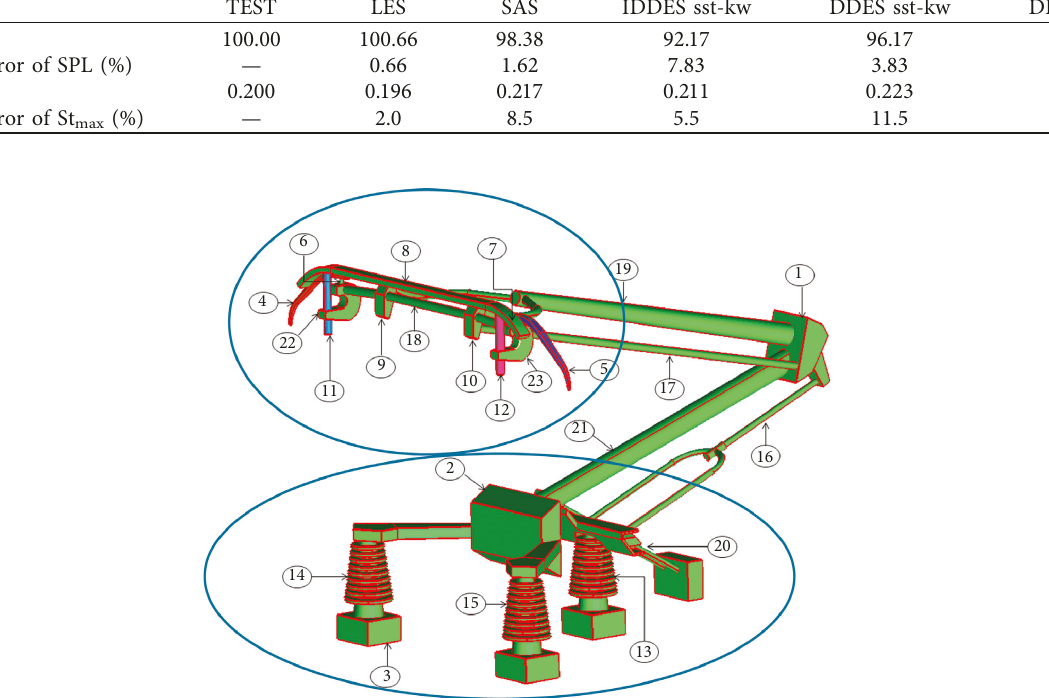
Figure 9: Geometric structure of the pantograph.1: the arm knuckle, 2: the bottom frame, 3: the base, 4: horn 1, 5: horn 2, 6: horn support 1, 7: horn support 2, 8: the panhead, 9: panhead knuckle 1, 10: panhead knuckle 2, 11: panhead support 1, 12: panhead support 2, 13: the rod insulator, 14: supporting insulator 1, 15: supporting insulator 2, 16: the rod, 17: the balance rod, 18: the balance beam, 19: the upper arm frame, 20: the push/pull shaft, 21: the lower arm, 22: supporting frame 1, and 23: supporting frame